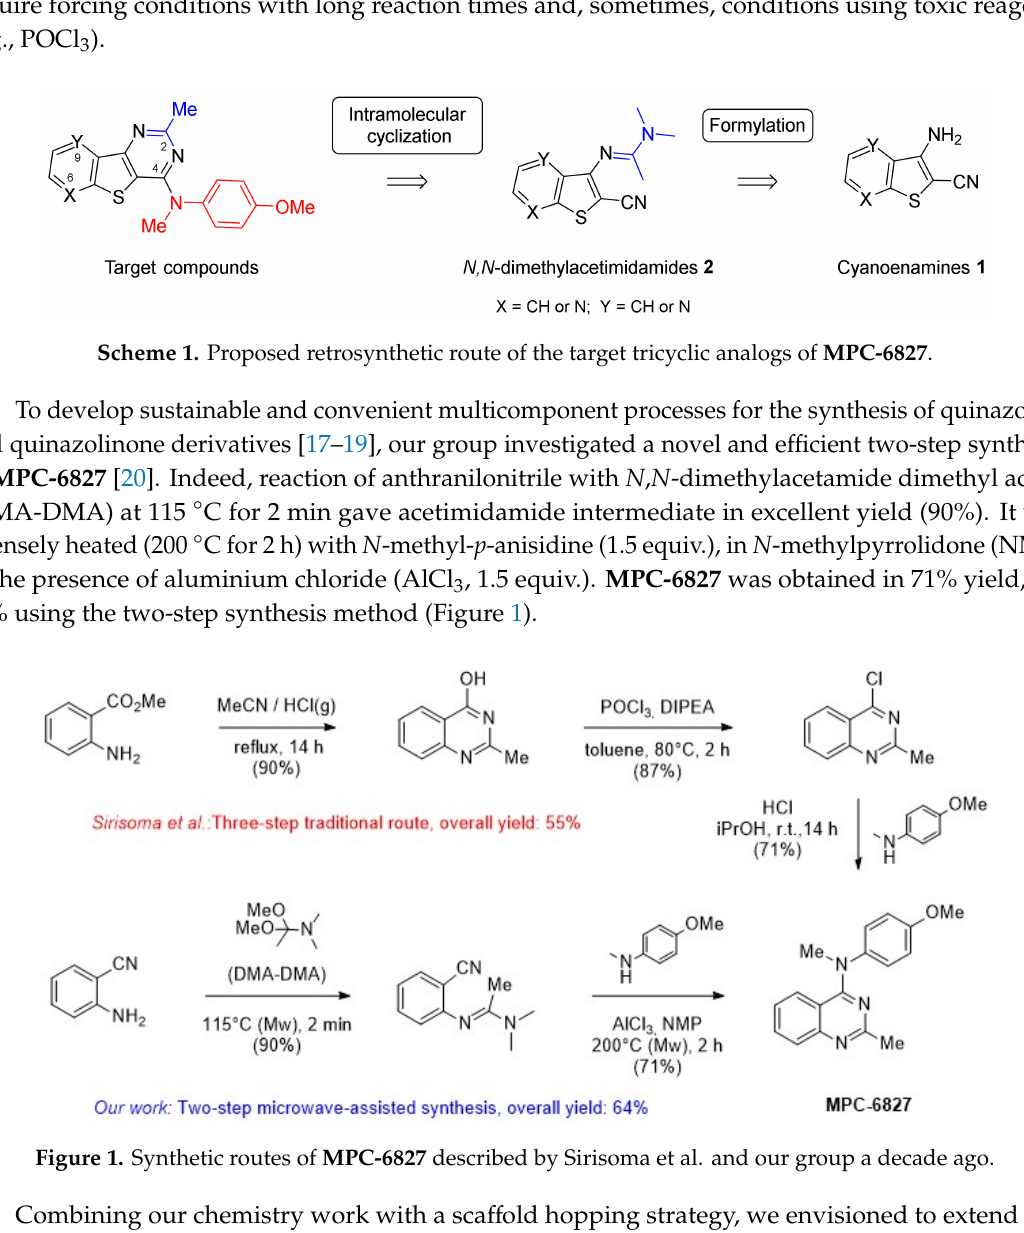
Figure 2. Structure of MPC-6827 and N -(4-methoxyphenylamino)-2-methyl benzo-, pyrido- or pyrazino-thieno[3,2- d ]pyrimidine derivatives envisioned in this work.